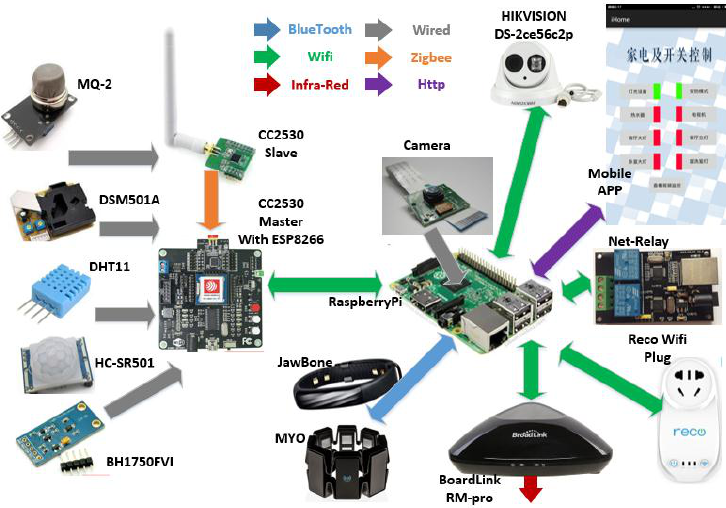
Figure 9. Draft architecture of the sensing home.